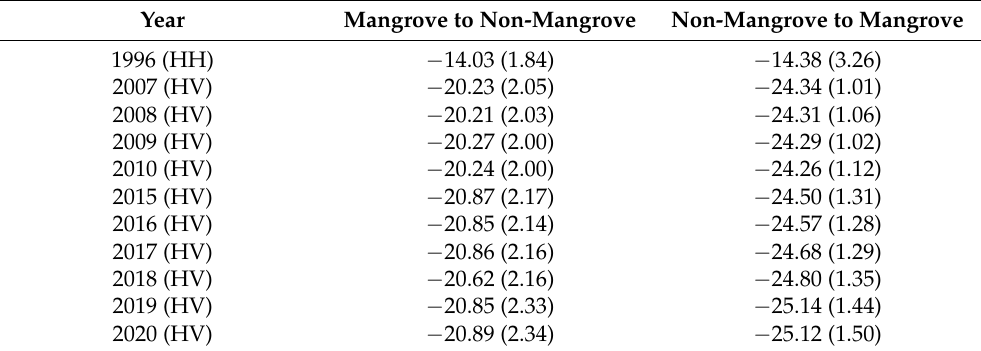
Table 3. The average and standard deviations of the thresholds used to separate mangroves and non-mangroves changes.